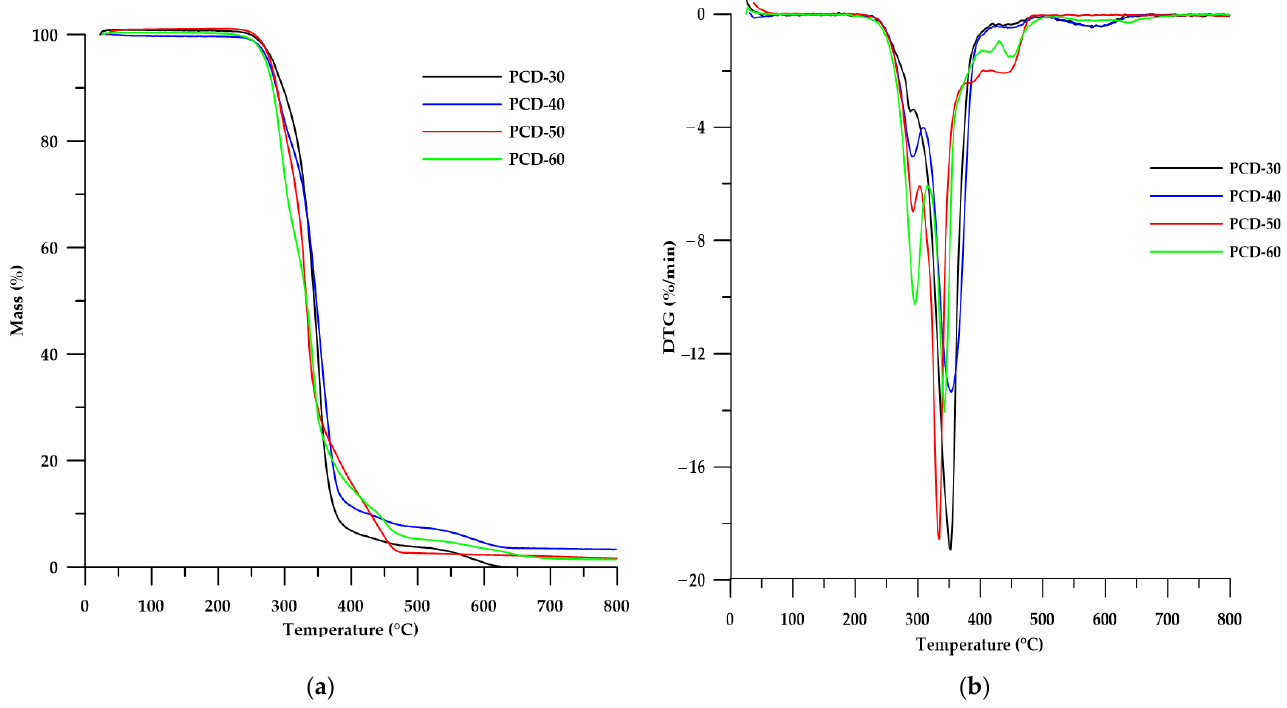
Figure 7. TG ( a ) and DTG ( b ) curves of the